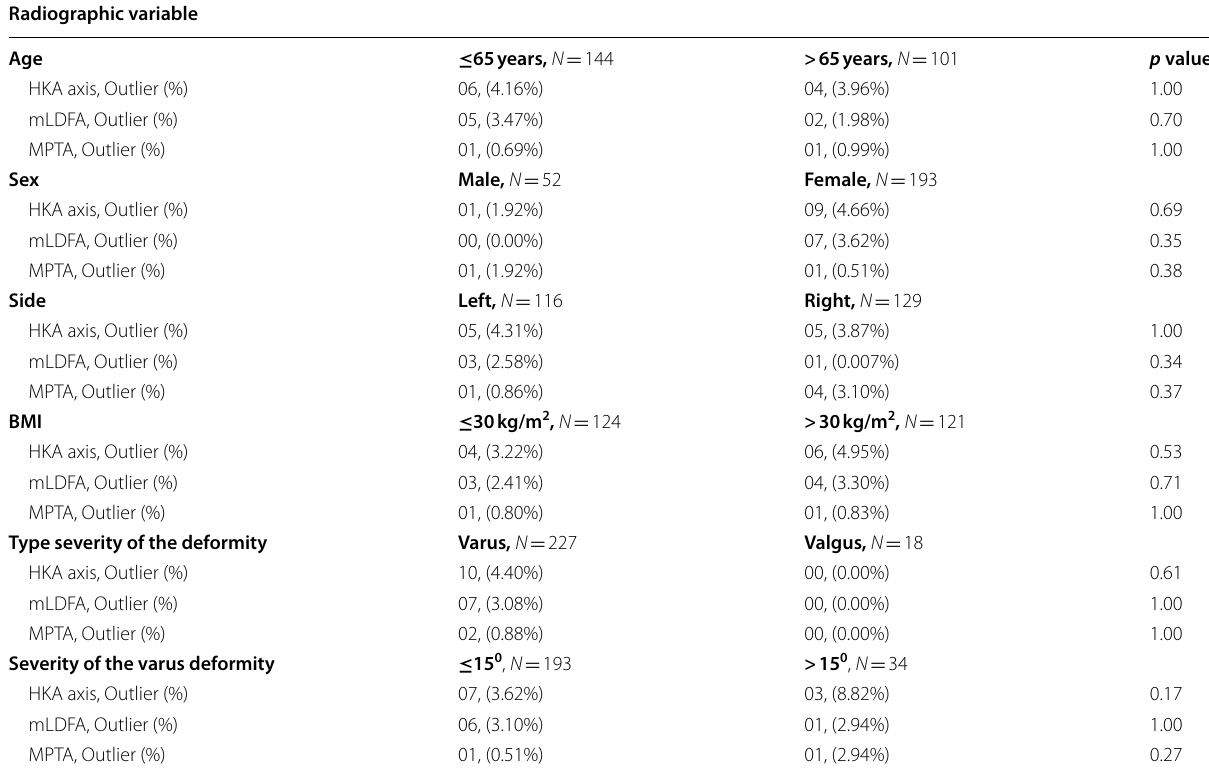
Table 3 Comparison of outliers in primary variables in groups stratified by age, sex, side, BMI and type and severity of the deformity Radiographic variable